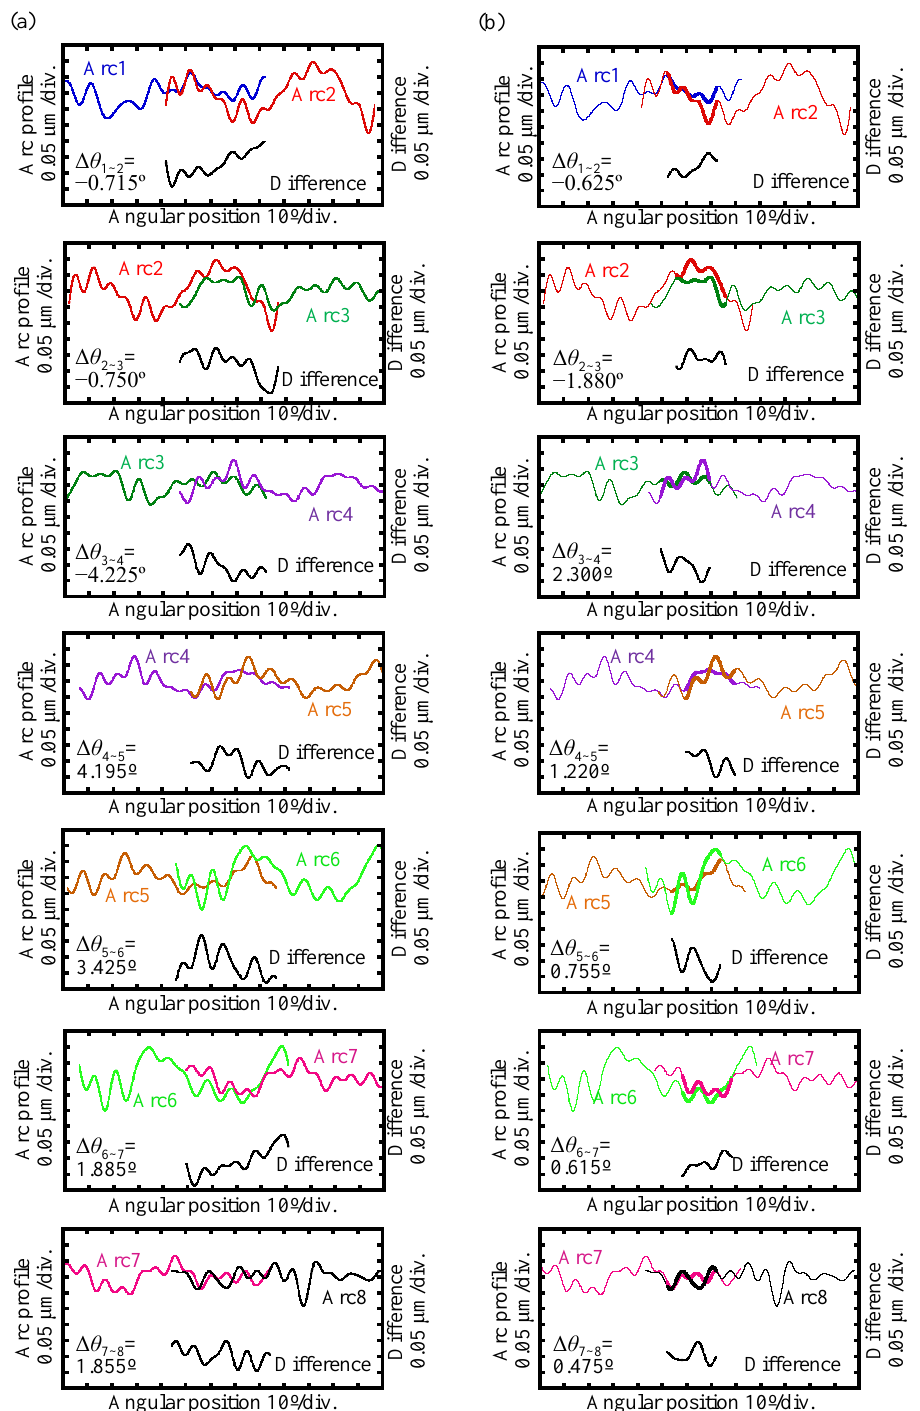
Figure 10. Stitched neighboring arc-profiles from the eight arc-profiles: ( a ) Stitching by employing all data in the overlapped region; ( b ) Stitching by employing the profile data in the overlapped region except the edge region in an arc to be stitched.